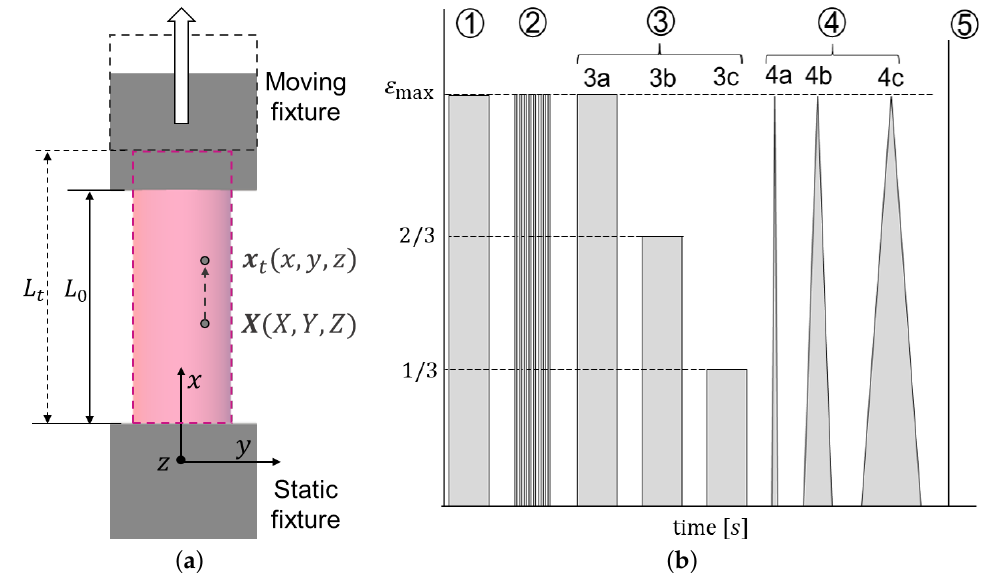
Figure 1. ( a ) Experimental setting measurements: the coordinate system is centered on the static fixture with the x axis parallel to the load direction, and a position change from the initial X to the deformed x t configuration is represented. ( b ) Cyclic and relaxation test stages scheme: (1) load-holding to maximum strain ( ε max ), (2) fast load/unload cycle stage to maximum strain, (3) load-holding to ε max , 2/3 · ε max and 1/3 · ε max , (4) load and unload to ε max at 0.01,0.1,1 s − 1 and (5) load to